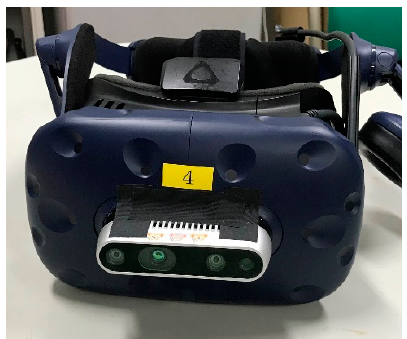
Figure 1. HTC VIVE Pro with RealSense.